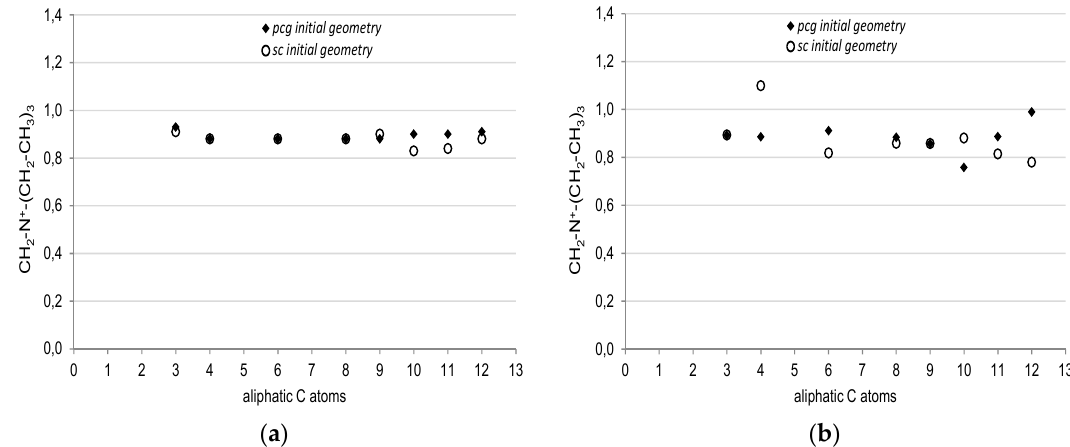
Figure 6. DFT calculated net charge of the ammonium group as a function of the carbons number of the AATEABs aliphatic chain (( a ) Löwdin, ( b ) ESP).